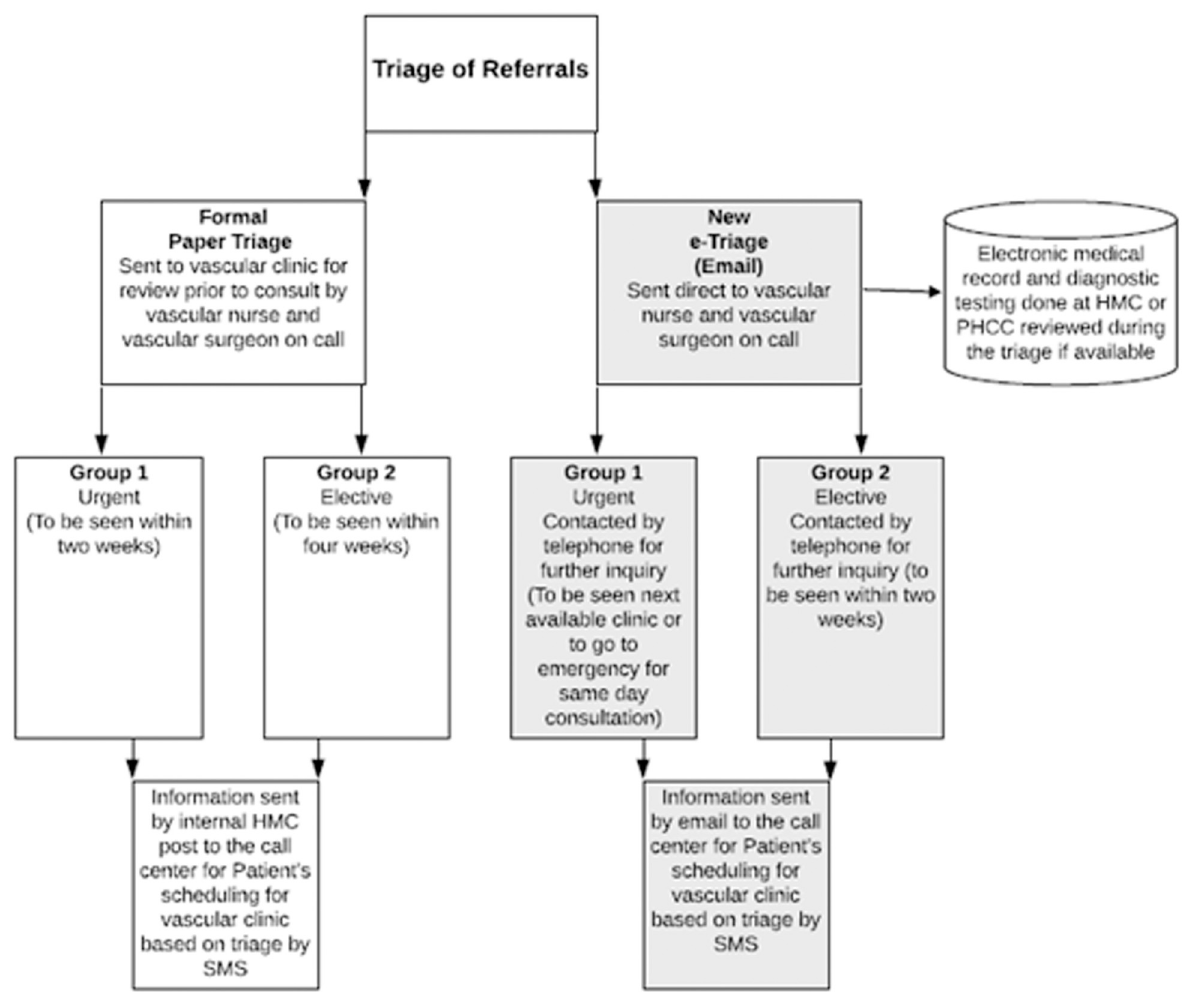
Fig 2. Triage of referrals at the vascular surgery clinic at Hamad General